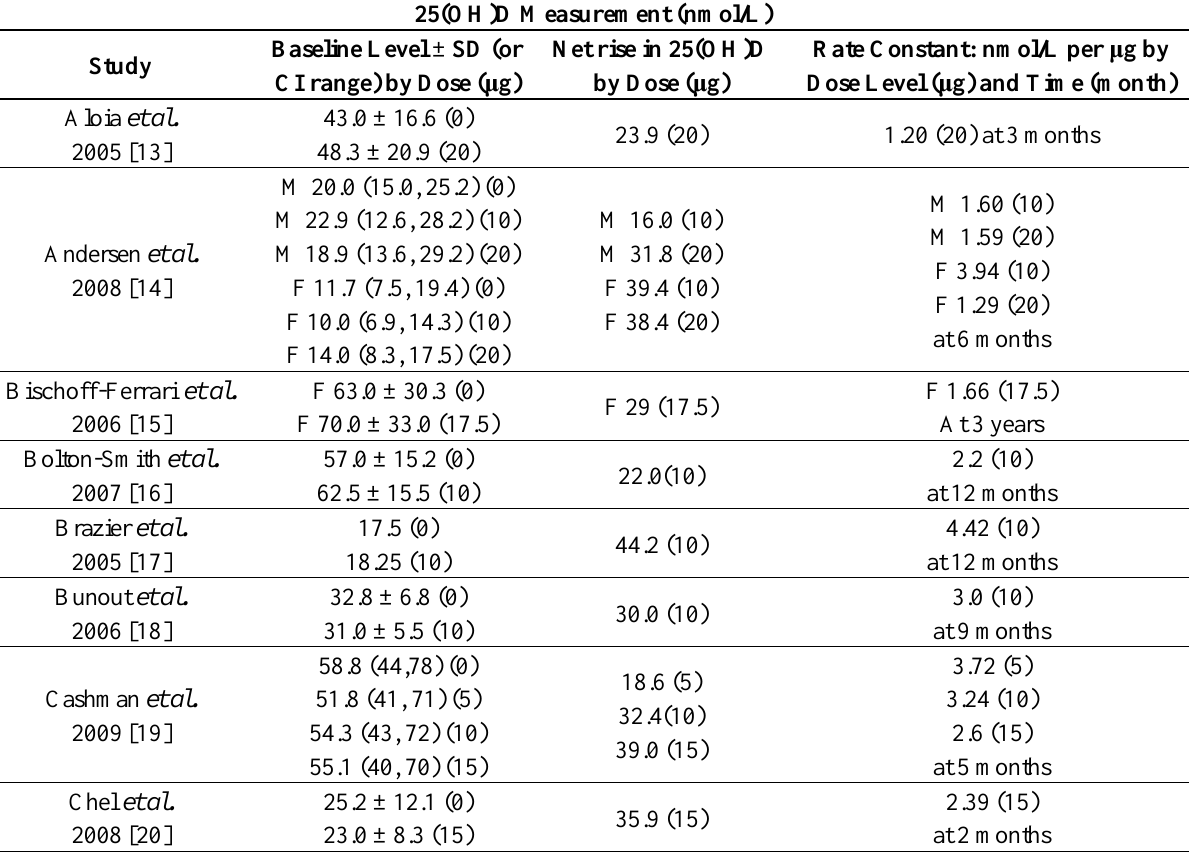
Table 1. Changes in levels of 25-hydroxyvitamin D in vitamin D intervention studies using small to moderate doses (5–20 μg) in supplements or fortified